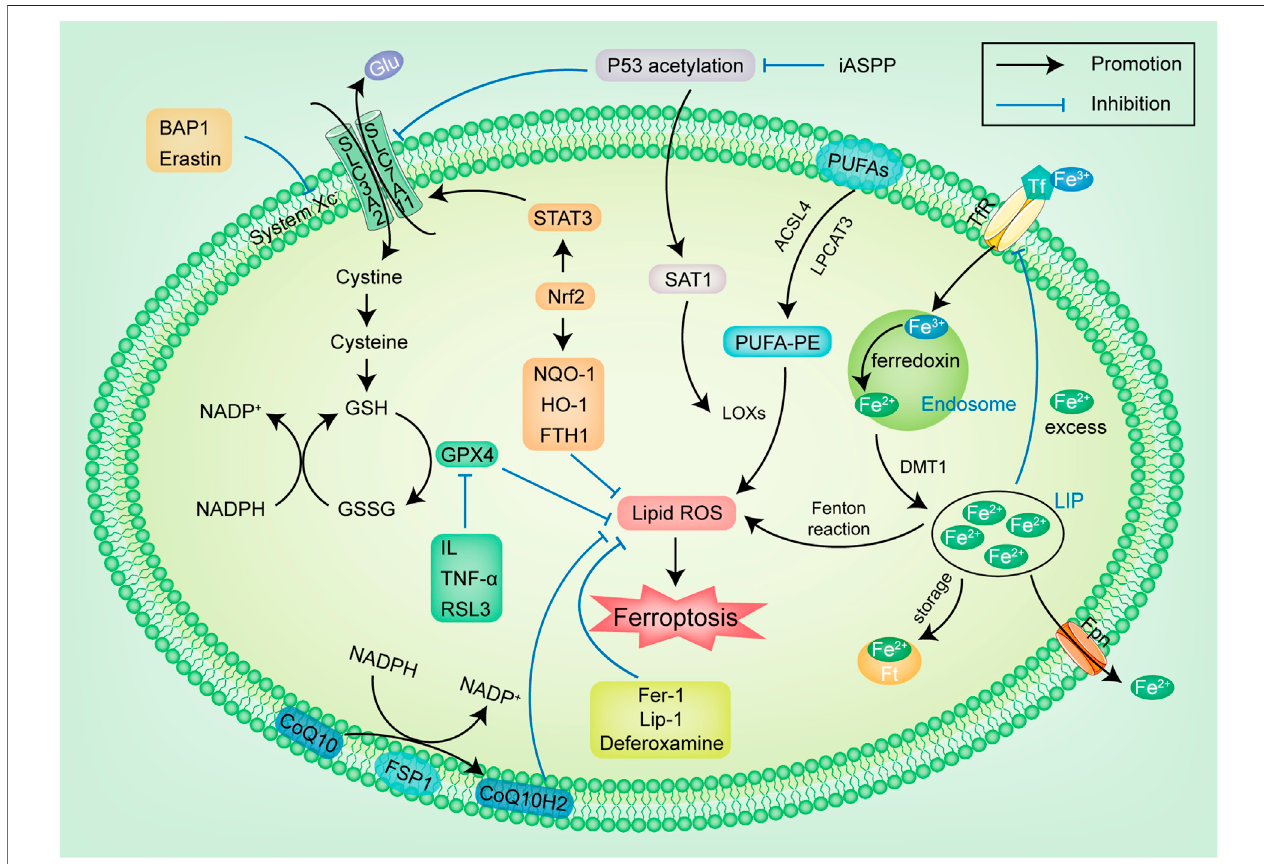
FIGURE 1 | The regulatory pathways of ferroptosis. The fi gure shows the regulation pathway of ferroptosis, which can be simply summarized into two types. The fi rst type is the metabolic pathways related to ferroptosis, such as iron metabolism, lipid metabolism and amino acid metabolism pathways; The second type is the signaling pathway related to ferroptosis, such as p53, Nrf2, FSP1 pathways. Glu: glutamic acid; GSH: glutathione; GSSG: oxidized glutathione; NADPH: nicotinamide adeninedinucleotidephosphate;GPX4:glutathioneperoxidase4;IL:Interleukin;TNF- α :tumornecrosisfactor- α ;RSL3:RAS-selectivelethal3;Nrf2:nuclearfactor erythroid-derived 2; STAT3: signal transducer and activator of transcription-3; NQO-1: NADPH-quinone oxidoreductase-1; iASPP: inhibitor of apoptosis-stimulating protein of p53; SAT1: spermidine/spermine N1-acetyltransferase 1; LOXs: lipoxygenases; ROS: reactive oxygen species; FTH1: ferritin heavy chain 1; DMT1: divalent metaliontransporter-1CoQ10:coenzymeQ10;Fpn:ferroportin;TfR:transferrinreceptor;Ft:ferritin;LIP:labileironpool;Lip-1:liproxstatin-1;Fer-1:ferrostatin-1;FSP1: ferroptosis suppressor protein 1.